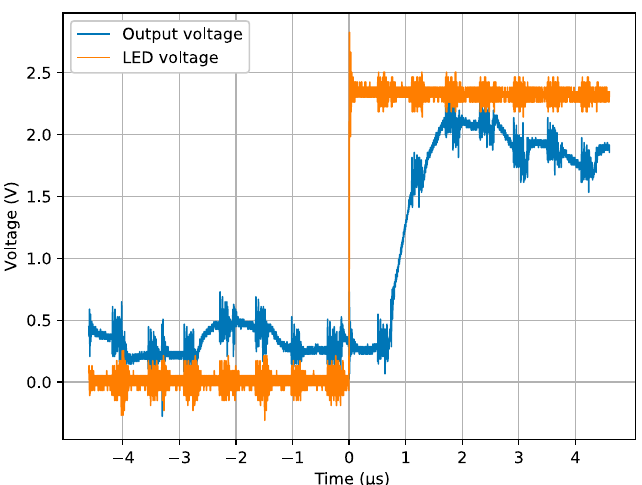
Figure 12. Output and LED voltages measured with a digital 1 GHz oscilloscope. Pixel-reading period was 560 ns.